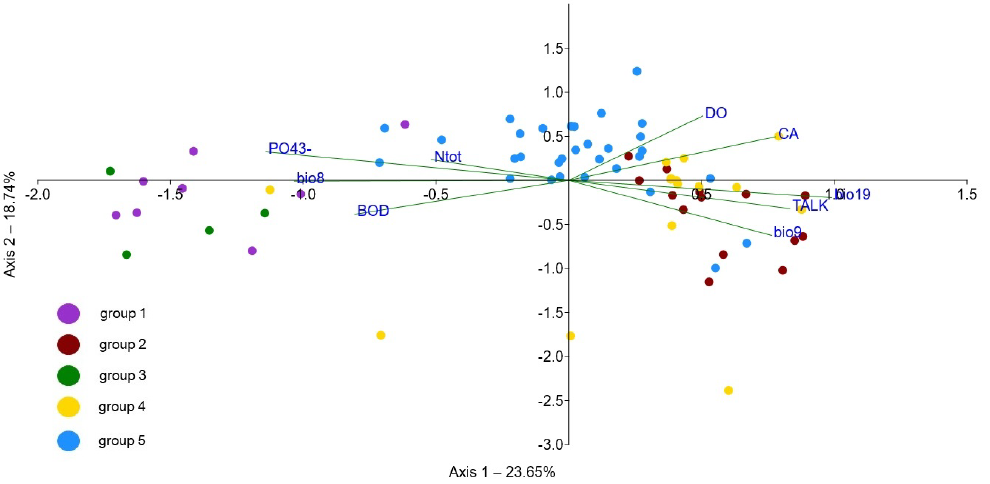
Figure 9. CCA ordination biplot with sampling sites belonging to different TWINSPAN groups and environmental variables (CA—catchment area, BOD—biochemical oxygen demand, DO—dissolved oxygen, N tot —total nitrogen, PO 43 − —orthophosphates, TALK—total alkalinity, bio8—mean temper- ature of the wettest quarter, bio9—mean temperature of the driest quarter, bio19—precipitation of coldest quarter).